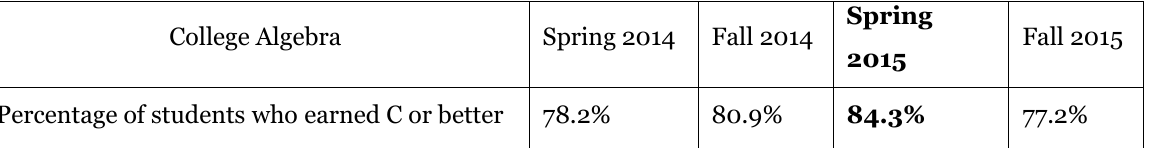
Percentage of Students Who Earned C or Better